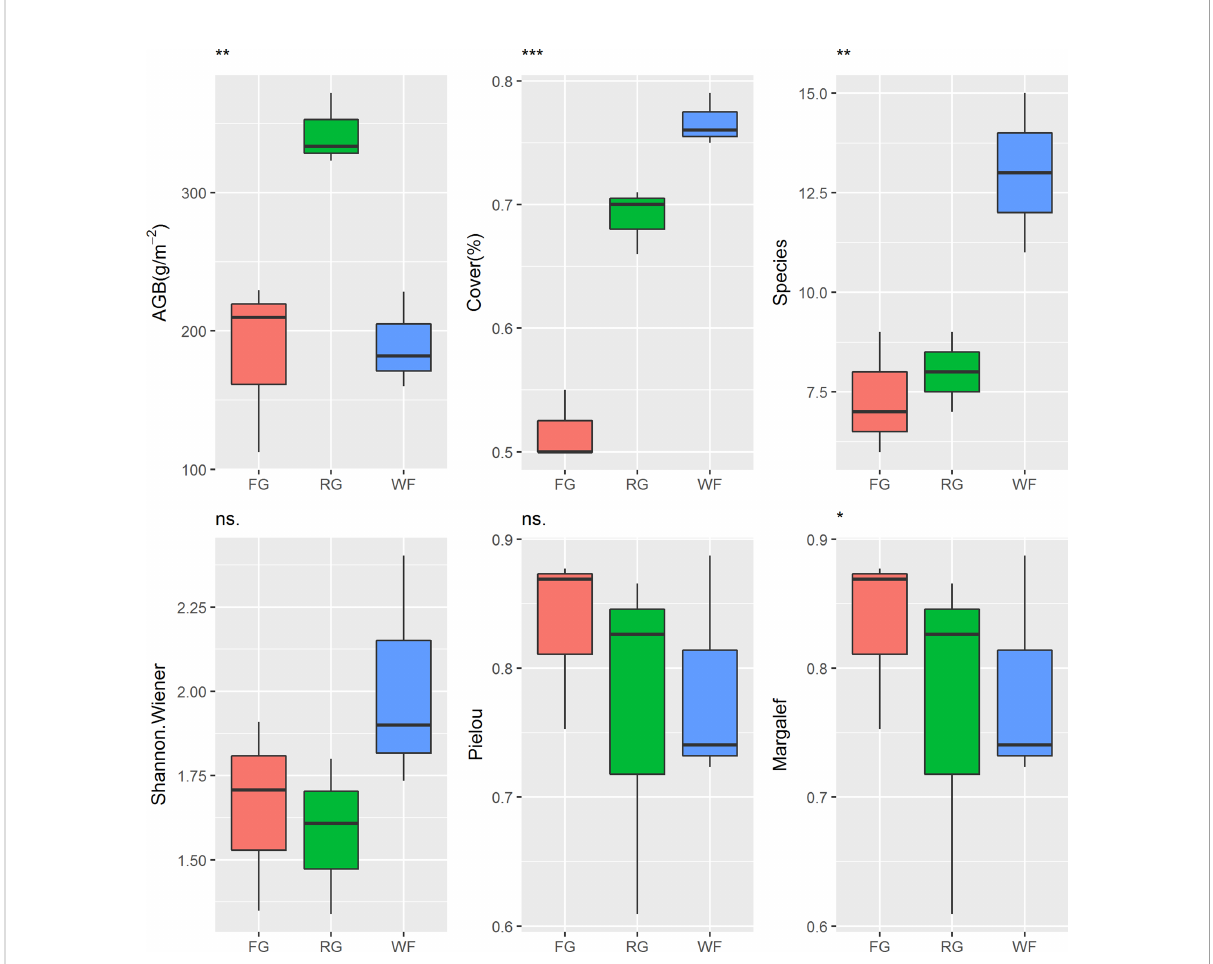
FIGURE 3 Effects ofdifferent grassland managementsonvegetationcharacteristics at Maqin alpine meadow. AGB: aboveground biomass, Cover:vegetation coverage, Species: number of species, Shannon-wiener: Shannon-wiener index,Pielou: Pielou index, Margalef: Margalef index, FG: free grazing,RG: arti fi cial grass planting, WF: enclosure; “ *** ” , “ ** ” , “ * ” and “ ns. ” represent signi fi cant relationship of P < 0.001, P< 0.01, P< 0.05 and P >